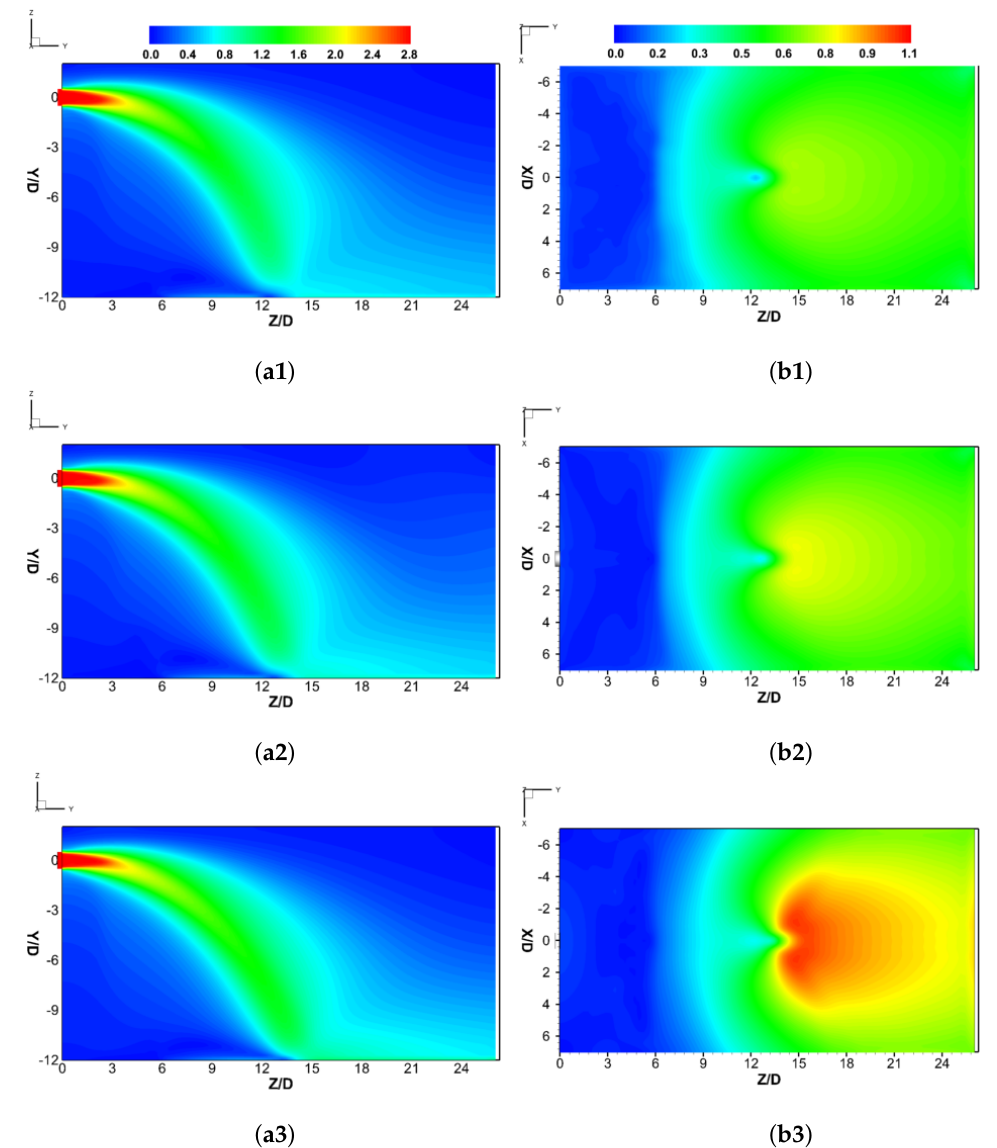
Figure 7. Contour plots of air velocity magnitude in the Y-Z middle plane for Case-1 to Case-3 ( a1 – a3 ) and near the ground wall surface for Case-1 to Case-3 ( b1 – b3